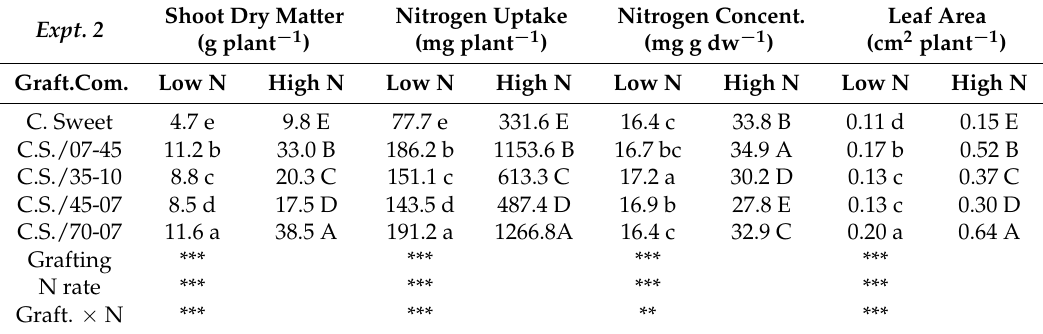
Table 3. Shoot dry matter, nitrogen uptake, nitrogen concentration and total leaf area of non-grafted and grafted watermelon cultivar (Crimson Sweet) onto four bottle gourd genotypes grown under